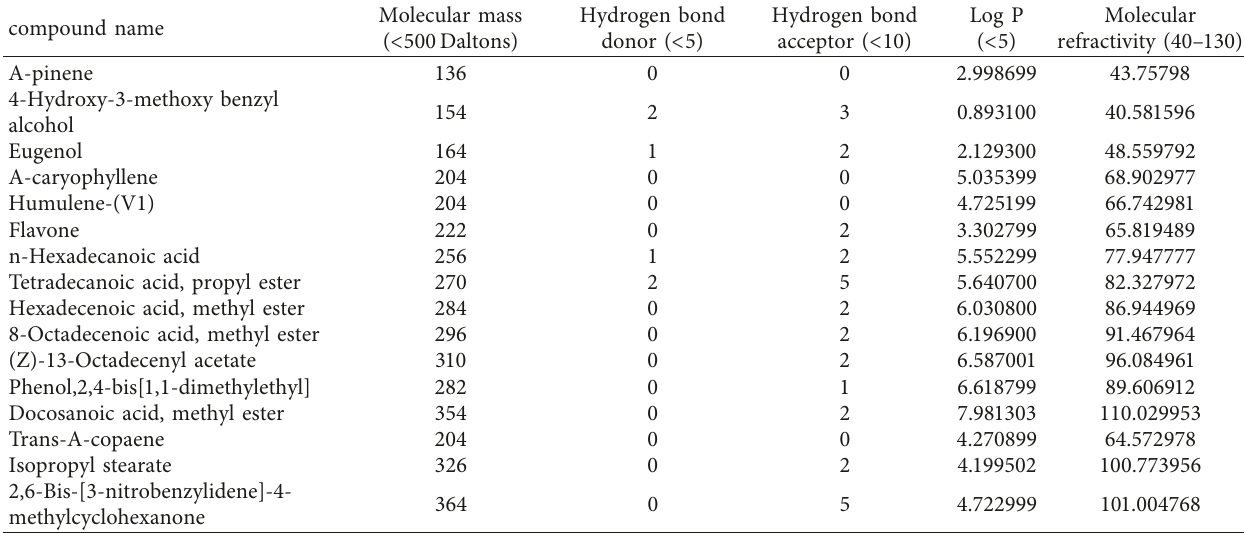
Table 2: Screening of ligands using Lipinski rule of